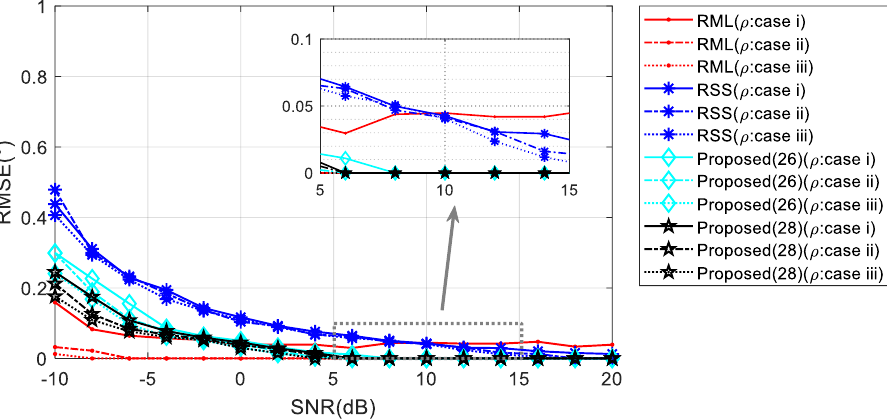
Figure 12. RMSE against input SNR with floating reflection coefficient when 𝜃 = 5°.